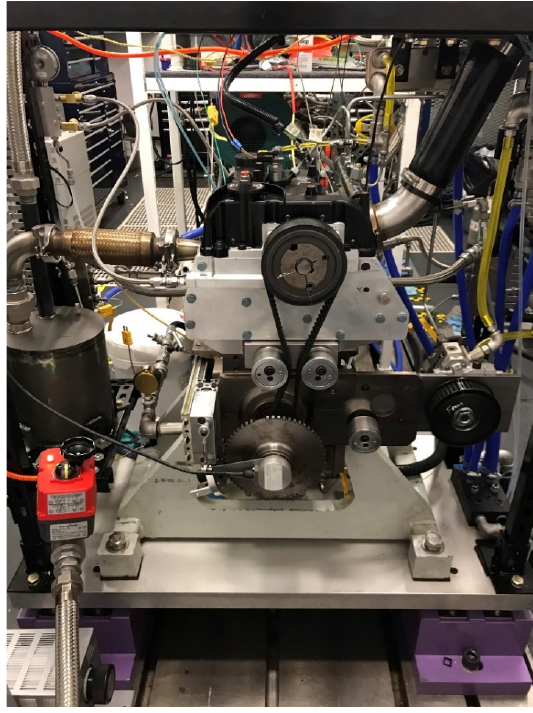
Figure 1. Experimental test cell.